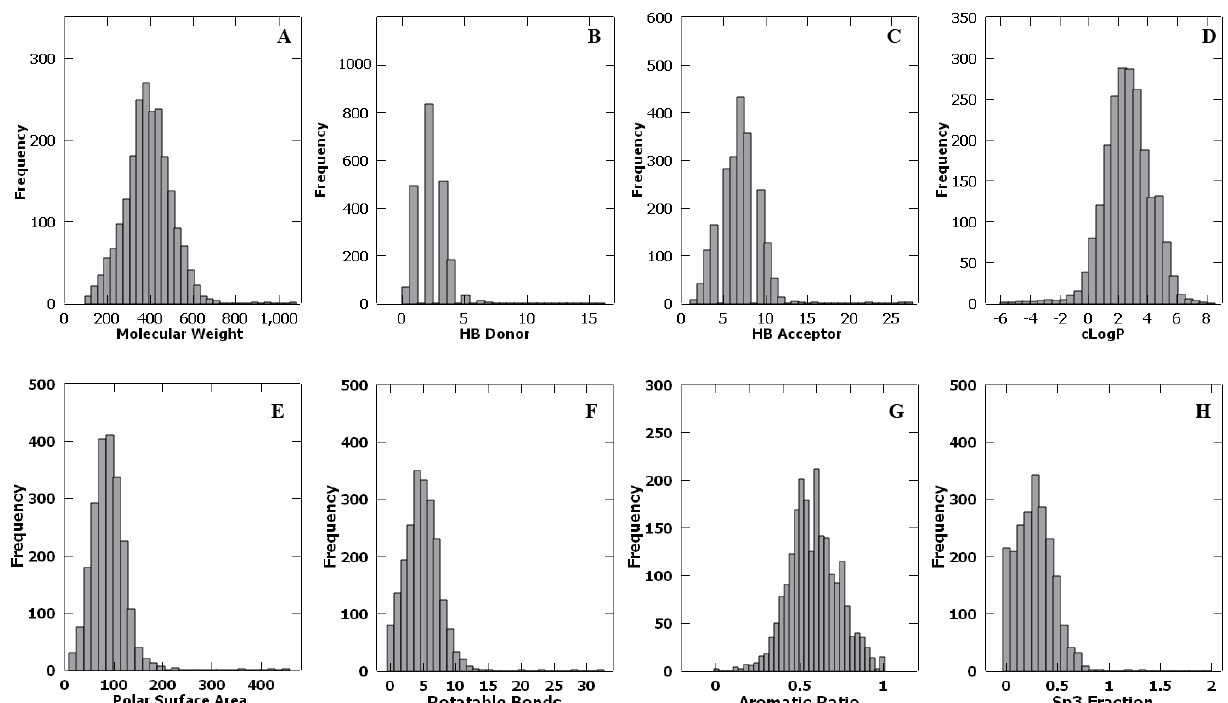
Figure 1. Distribution of molecular descriptors. ( A ) molecular weight (in Daltons); ( B ) number of HB donor atoms; ( C ) number of HB acceptor atoms; ( D ) calculated partition coefficient between octanol and water; ( E ) topological polar surface area (in Å 2 ); ( F ) number of rotatable bonds; ( G ) aromatic ratio; and ( H ) fraction of sp 3 carbon atoms.